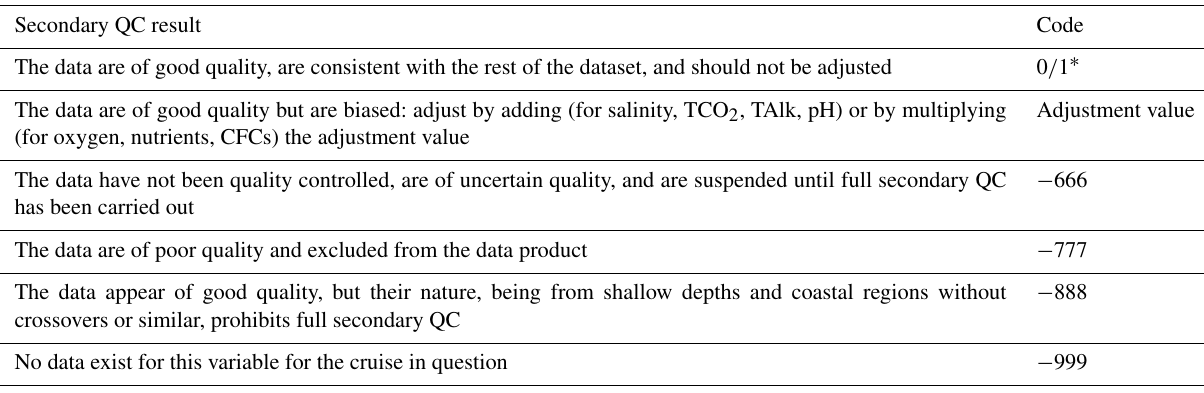
Table 5. Possible outcomes of the secondary QC and their codes in the online adjustment